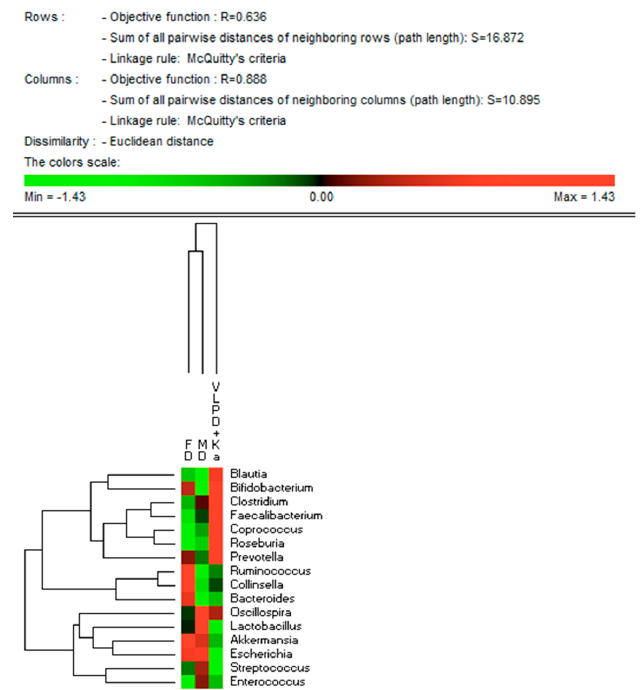
Figure 3. Bacterial genera associated to dietary regimens in intestinal microbiota of CKD patients. Average of relative abundance (%) of bacterial genera which were found in the fecal samples of patients with free diet (FD), Mediterranean diet (MD), or very low protein diet supplemented with alphaKappa (VLPD + Ka). Only genera showing statistical differences ( p < 0.05) in at least one dietary regimen were